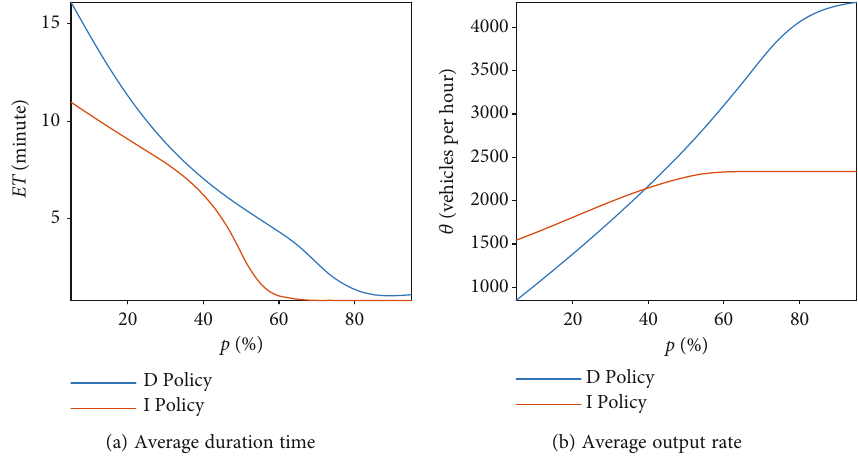
Figure 8: Comparison between the D policy and the I policy when SCV = 1 under a low tra ffi c intensity.